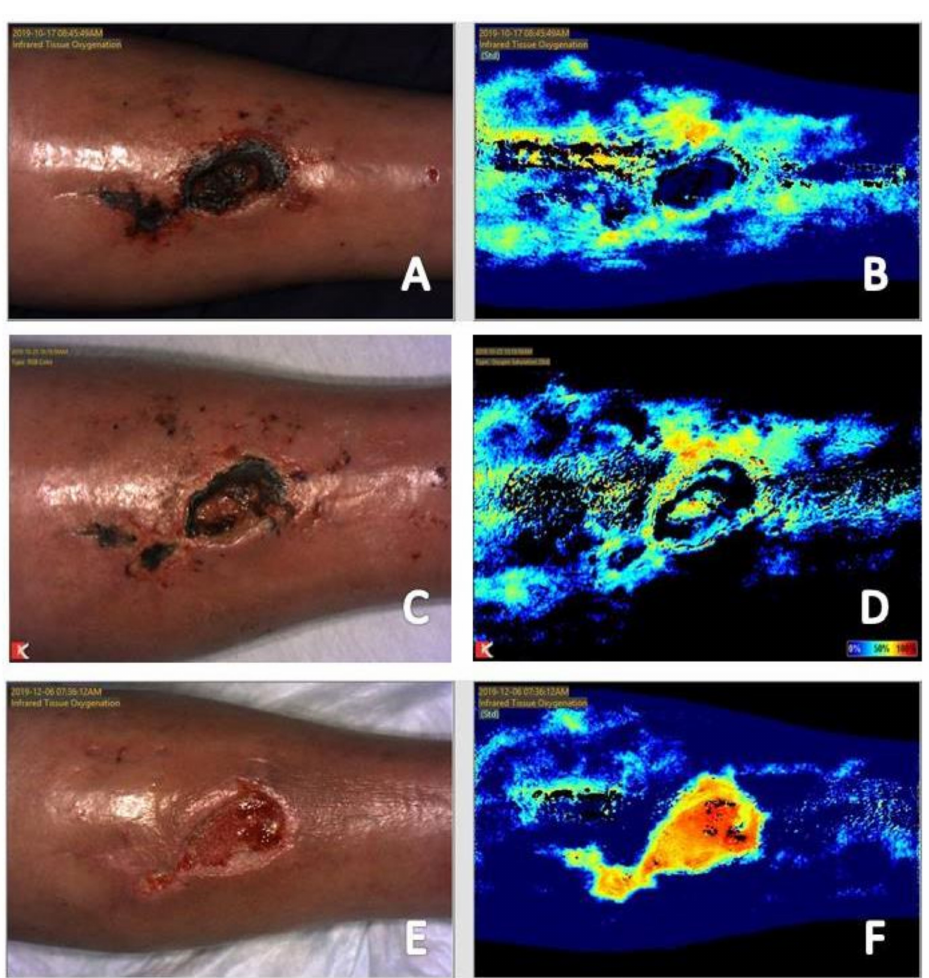
Figure 3. ( A ) Baseline clinical photograph; and ( B ) near-infrared image assessment of the left anterior leg taken prior to debridement and vascular intervention (17 October 2020). Note absence of